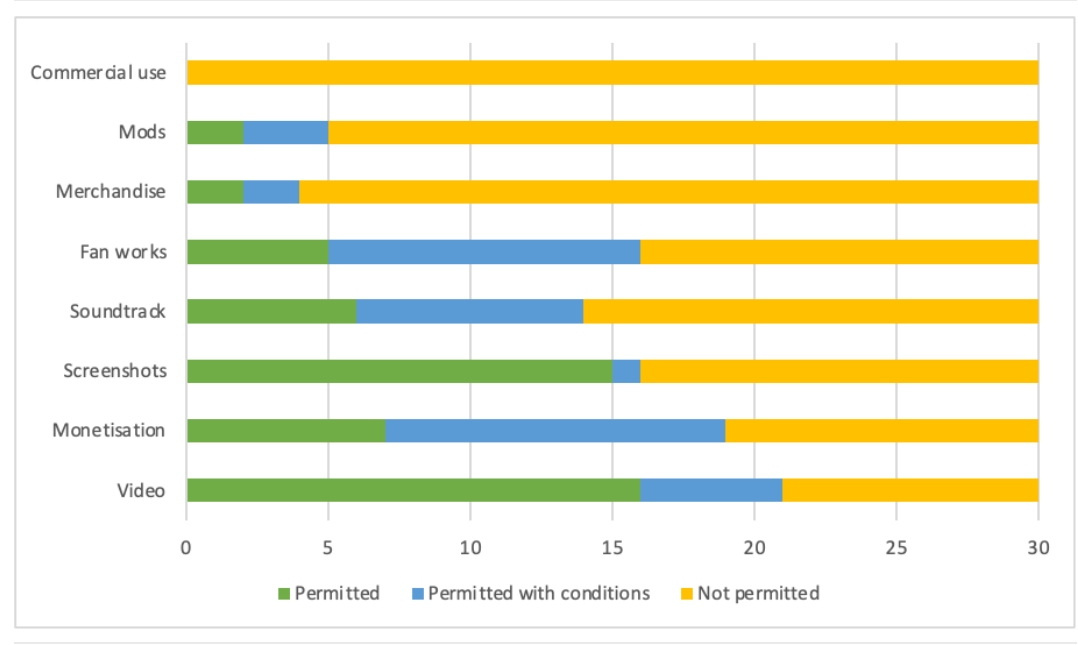
FIGURE 1: Bar chart showing level of permission by activity, scaled from least to most